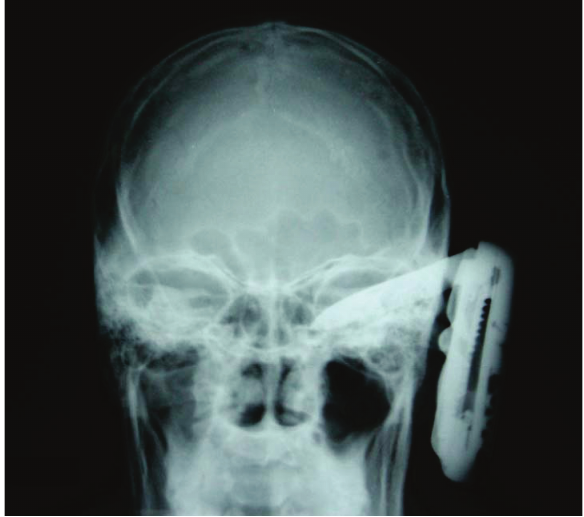
Figure 2 . Orbital and sinuses X-Ray showing extent of knife penetration into left orbit